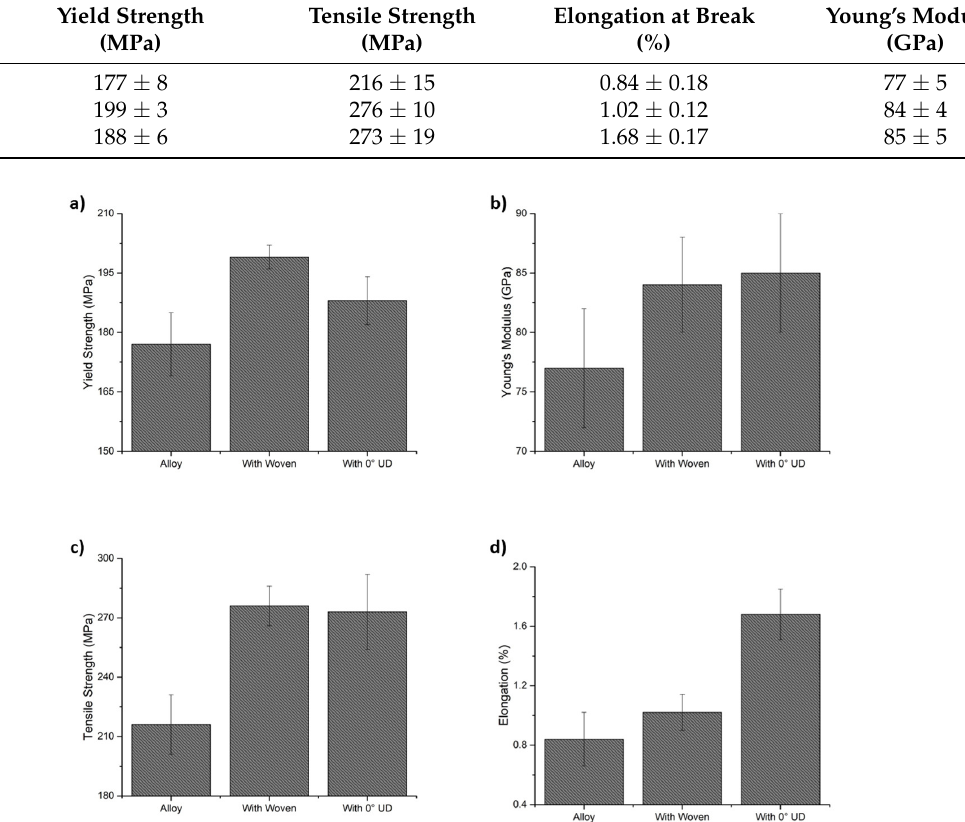
Figure 7. Results of the tensile tests: ( a ) yield strength; ( b ) Young's modulus; ( c ) tensile strength; and ( d ) elongation at ( d ) elongation at break.